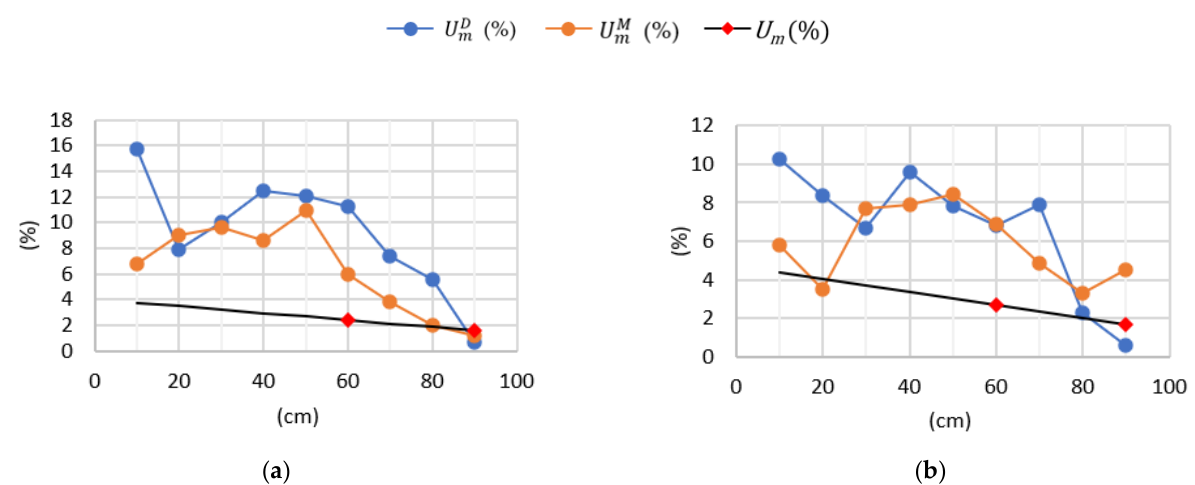
Figure 5. Validation of the internal pillar moisture by dielectric, microwave, and mass/invasive methods: ( a )—side 7A, ( b )—side 7B.